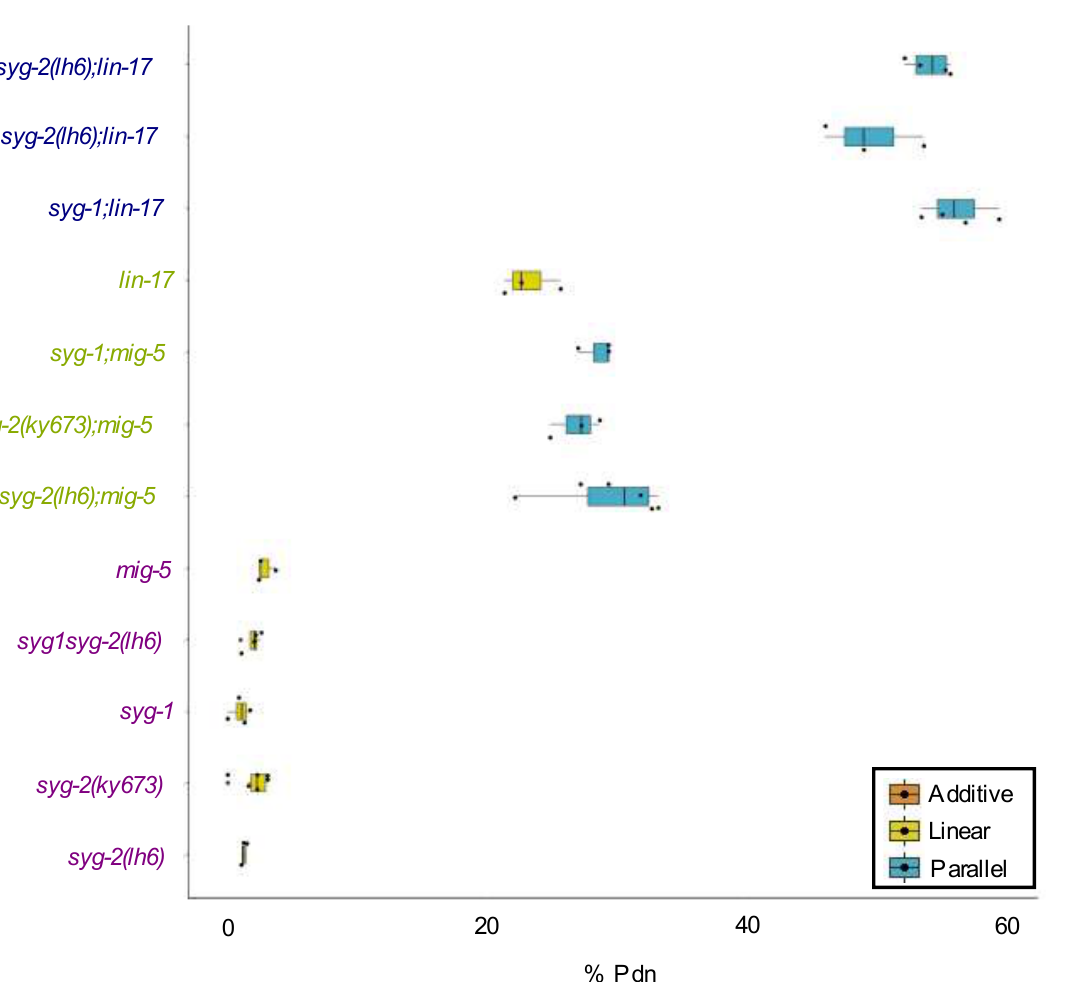
Figure 2. The Syg and Wnt pathways function in parallel. The percentage of animals displaying a Pdn is indicated by the boxplot. There are three significance groups ( A – C ). Each genotype within a group is not significantly different from the others in the same group but is significantly different from all genotypes in the other groups by pairwise comparisons. The color of the boxplot demonstrates the type of genetic interaction concluded by genetic analysis.